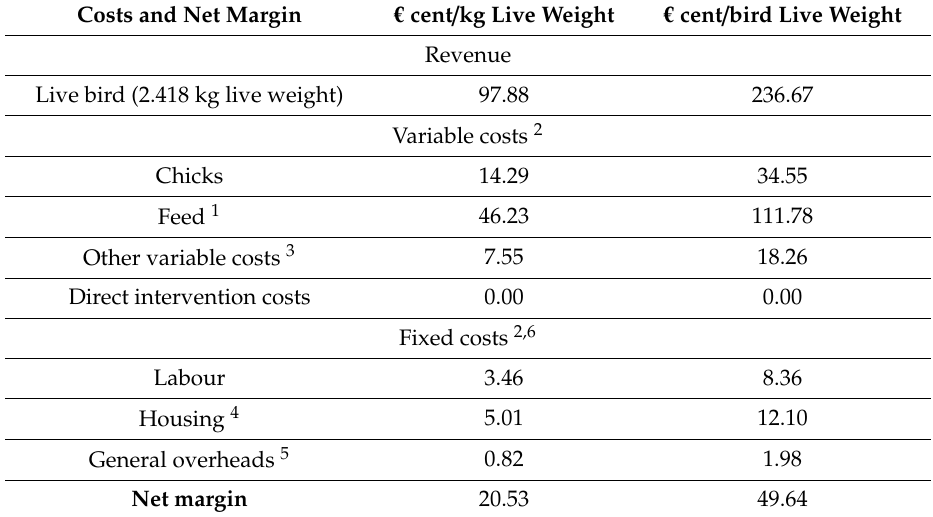
Table A1. Standard financial model for the broiler enterprise based on the control group (Treatment I). Costs and Net